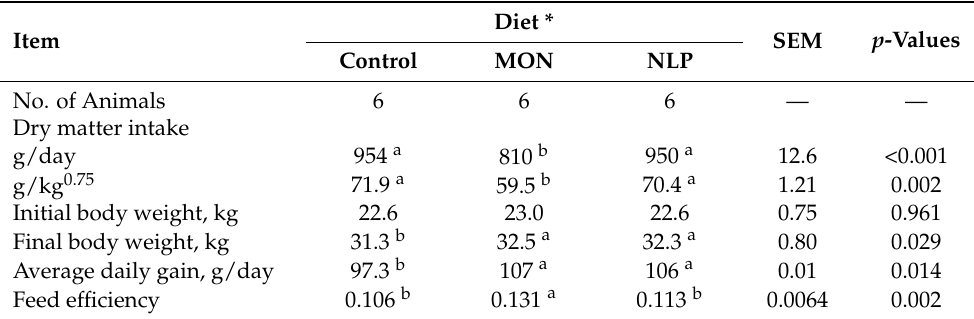
Table 2. Influence of neem leaf powder or monensin supplementation on growth performance of Omani growing lambs.